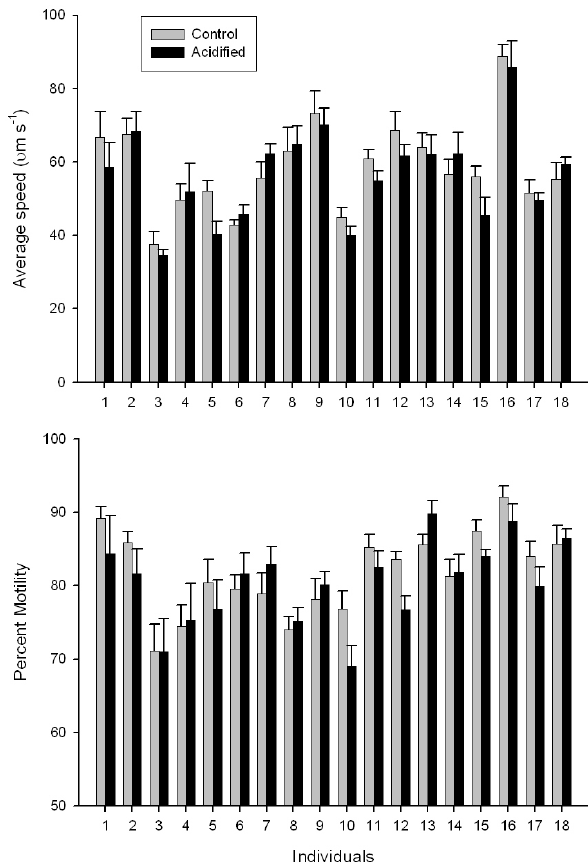
Fig. 1. Individual variability between males (1–18) in control (grey) and acidified (black) treatments for sperm swimming speed and percent motile sperm. Error bars denote the standard deviation from the mean between the five